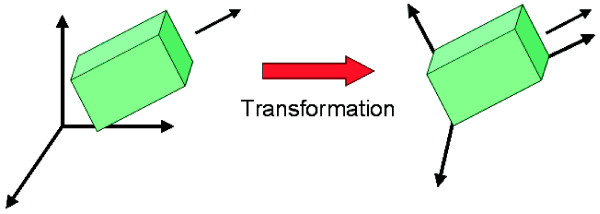
State space transformation. The idea of our method can be described more easily by considering a mechanical example: In order to model the movement of a mass in space one has to choose a certain coordinate system. However, if this coordinate system is not adjusted to the problem (like shown on the left site) the model equations will be more complicate than in a transformed coordinate system.